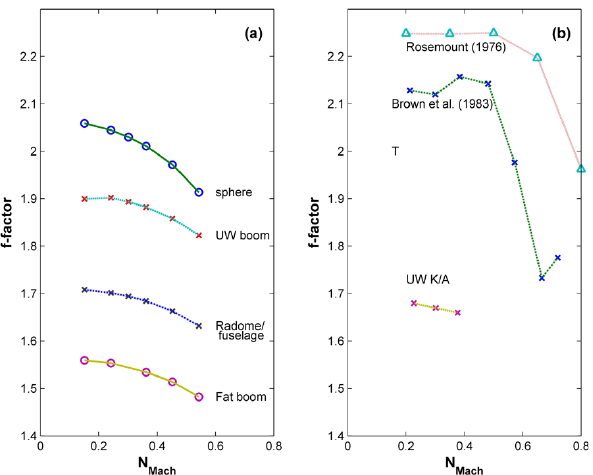
Fig. 7. Estimation of sensitivity factor f from (a) modeling and (b) values from Brown et al. (1983), (Rosemount, 1976), and so- lution to Eq. (A11) for UW King Air flight data. The point labeled “ T ” represents the value from determined from the wind tunnel tests of the R858